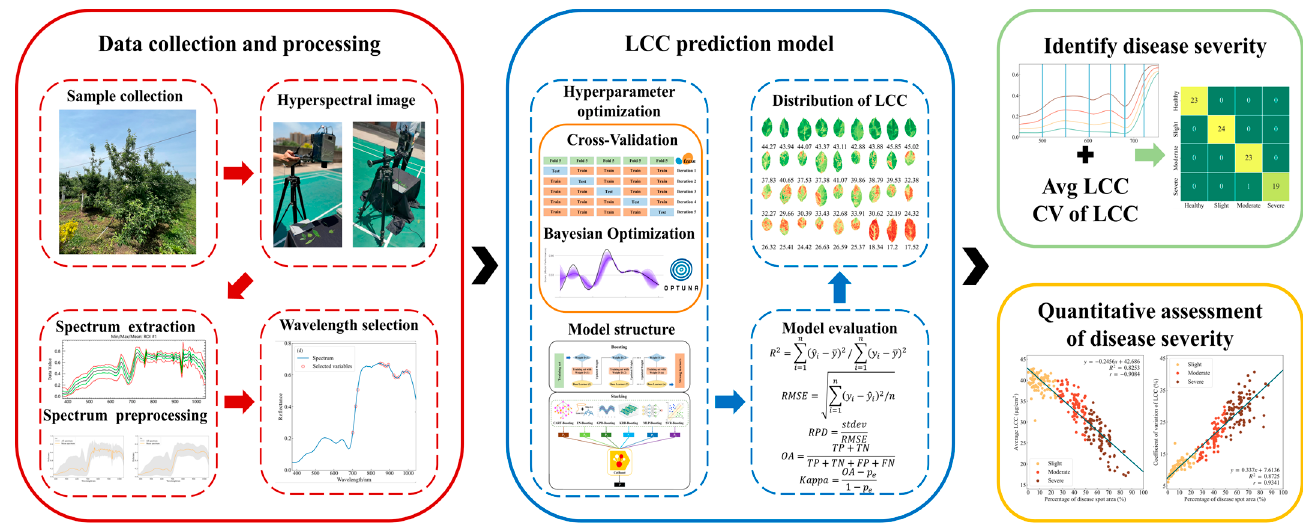
Figure 2. Flow chart for quantitative assessment of apple mosaic disease severity based on hyper- spectral images.